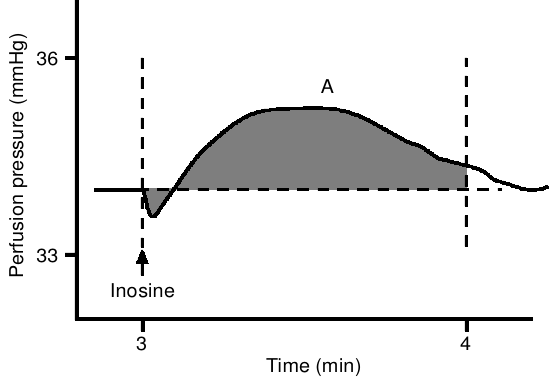
FIG. 1. Diagrammatic representation of a typical pressor response to a bolus injection of inosine (2.7 mg) in the rat hind limb perfused with GPSS L-NAME (100 m g). Record- ings were made on 1 mm squared paper. The pressor response to inosine in NS was calculatd as the difference between the number of squares in the shaded area above the baseline minus the number of squares in the shaded area below the baseline. The equivalent numbers of squares (above and below the baseline) after an injection of NS (0.2 ml) was calculated from the same preparation. The response to NS alone was then subtracted from the response to inosine in NS. Final results were expressed in arbitrary units (Fig. 2 and Table 1). The maximum ampli- tude of the response (in mm) was determined at